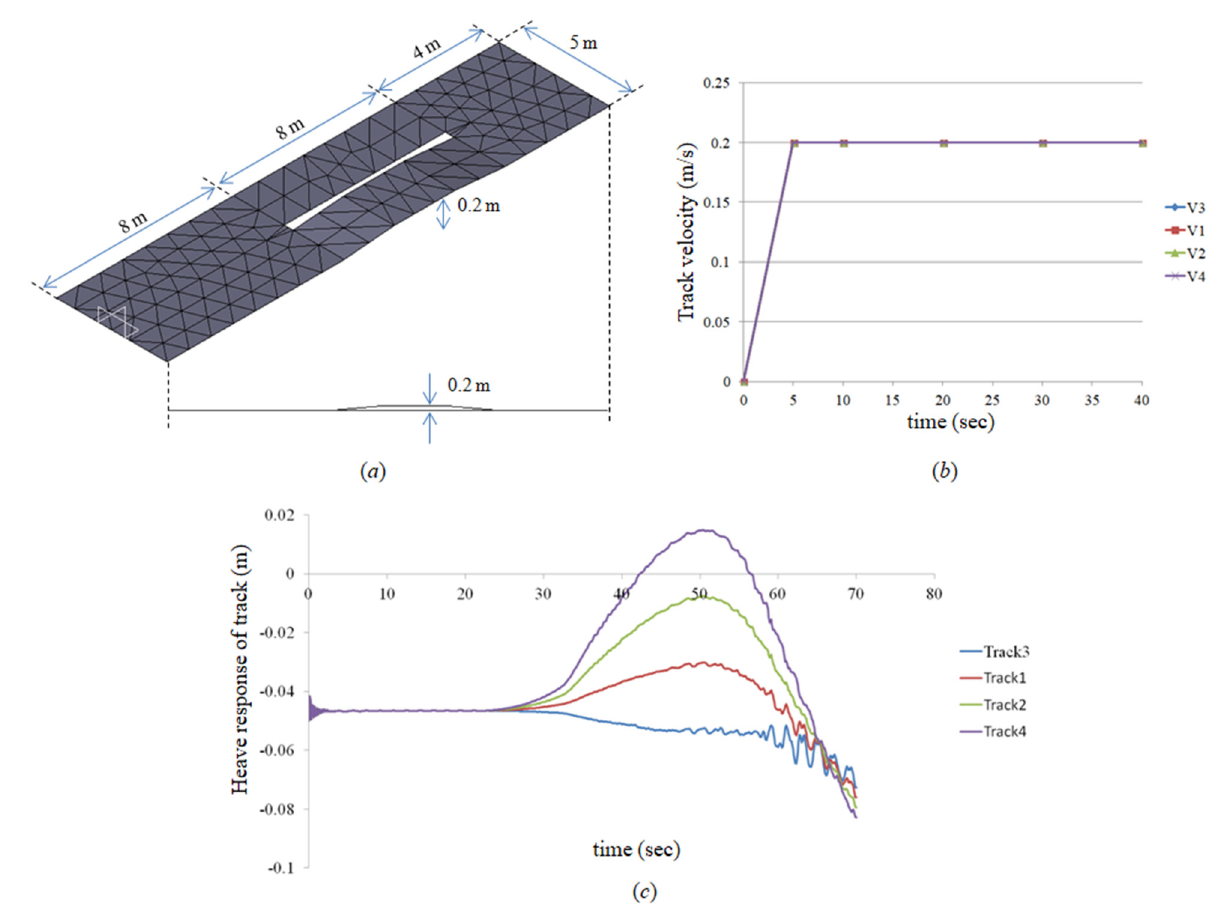
Figure 35. Three-dimensional ground application example: ( a ) bumper geometry of 3D ground, ( b ) input velocity of each track row, ( c ) Heave response of each track row.